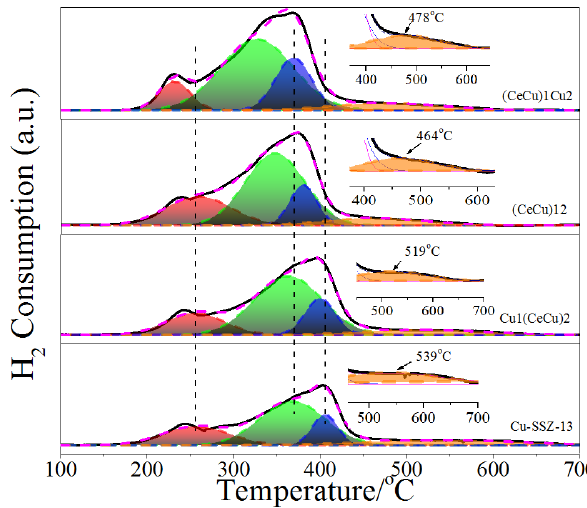
Figure 5. H 2 -TPR profiles of Cu-SSZ-13 and Ce-modified Cu-SSZ-13 catalysts. Table 2. Quantitative analysis of the TPR and TPD profiles of Cu-SSZ-13 and Ce-modified Cu-SSZ-13 catalysts. Samples